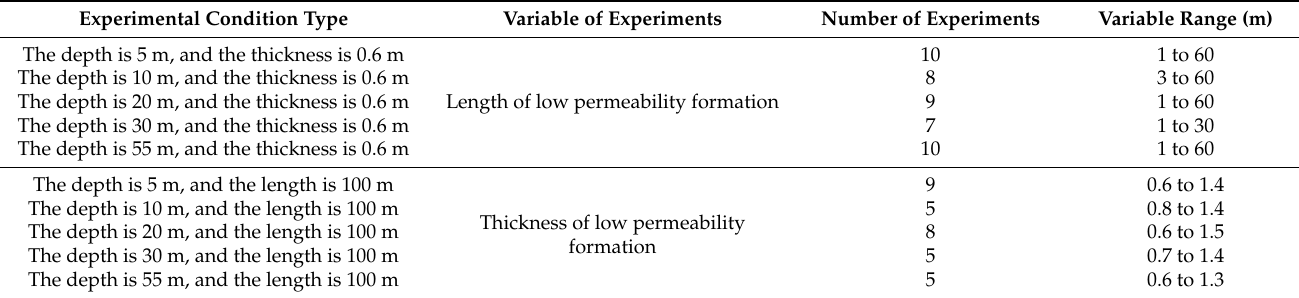
Table 2. The experimental condition type, variable of experiments, number of experiments, and variable range under the experimental condition of low permeability